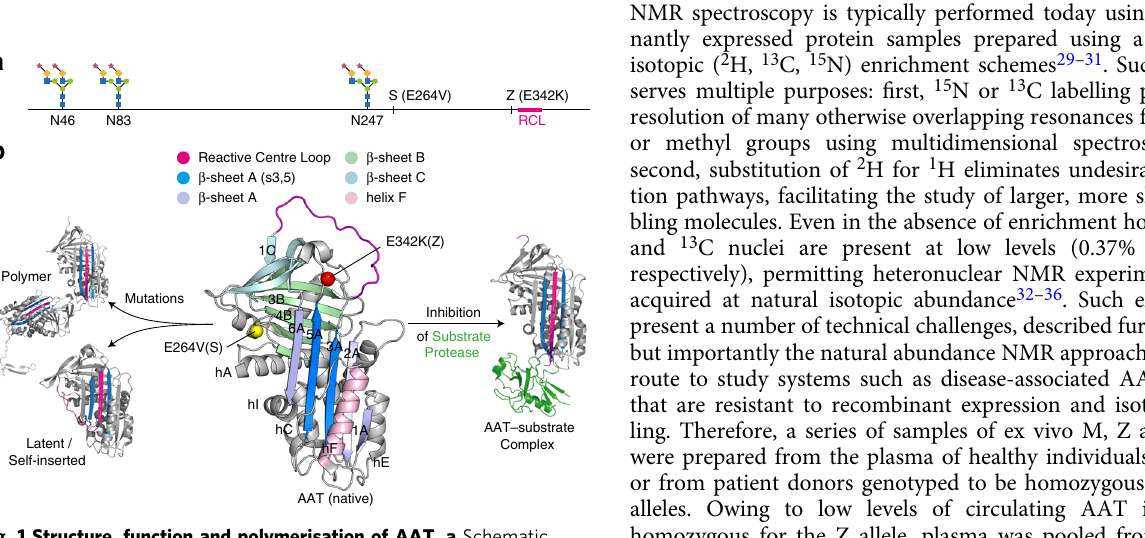
Fig. 1 Structure, function and polymerisation of AAT. a Schematic indicating the position of N -linked glycans (with the abundant M6 glycoform shown) 45 , disease-associated mutations and the reactive centre loop. b Crystal structures of recombinant AAT highlighting key structural features and the location of disease-associated mutations, and the large- scale conformational changes associated with function and